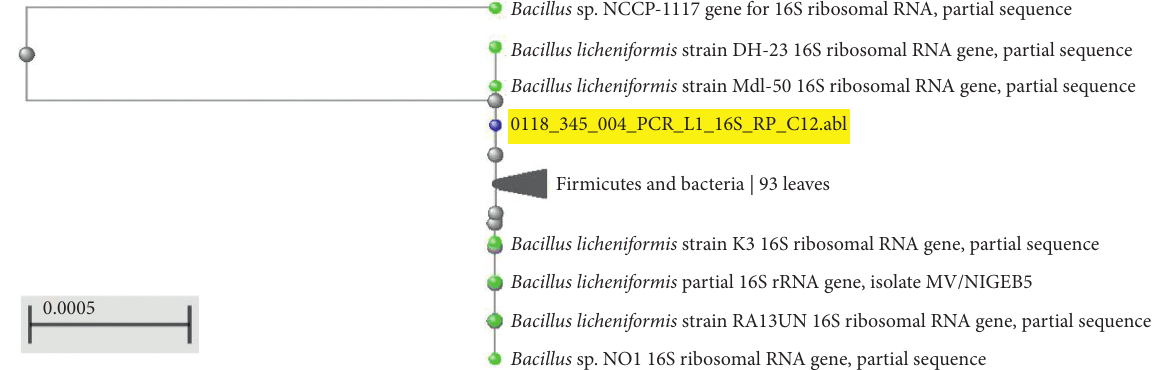
Bacillus sp. NCCP-1117 gene for 16S ribosomal RNA, partial sequence Bacillus licheniformis strain DH-23 16S ribosomal RNA gene, partial sequence Bacillus licheniformis strain Mdl-50 16S ribosomal RNA gene, partial sequence